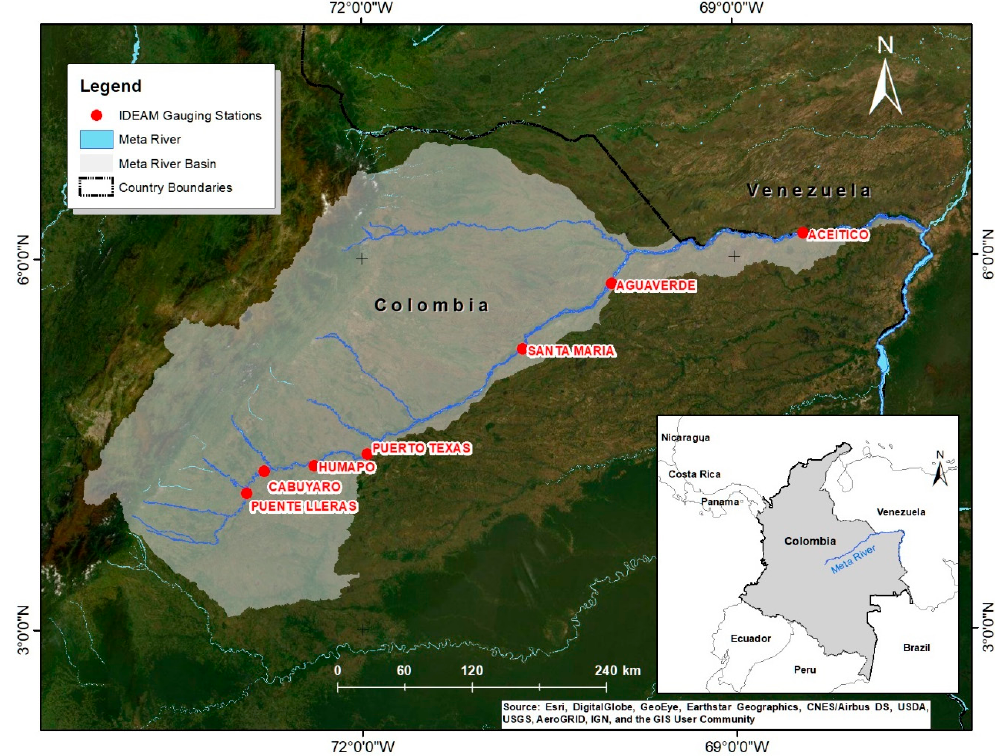
Figure 1. Location of the gauging stations along the Meta River.